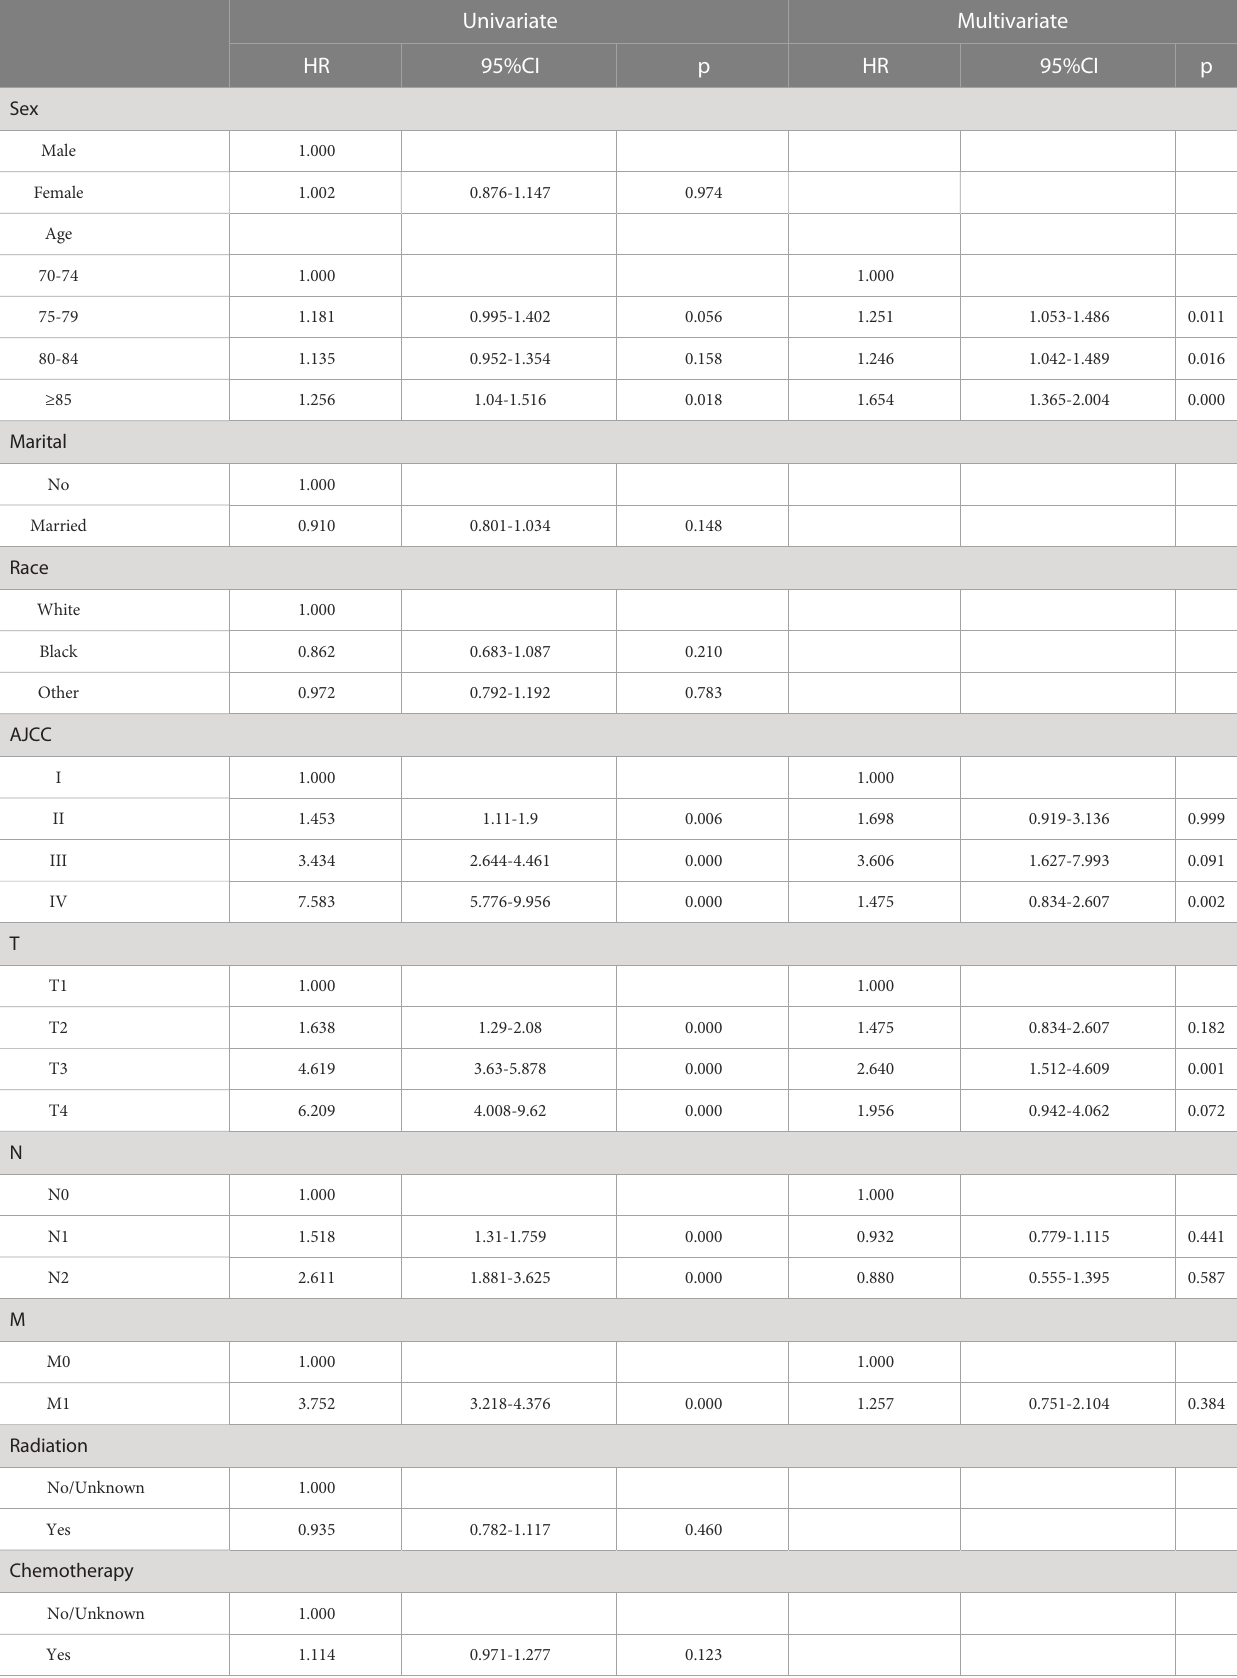
TABLE 6 Univariate and multivariate Cox regression analysis of CSS for patients underwent